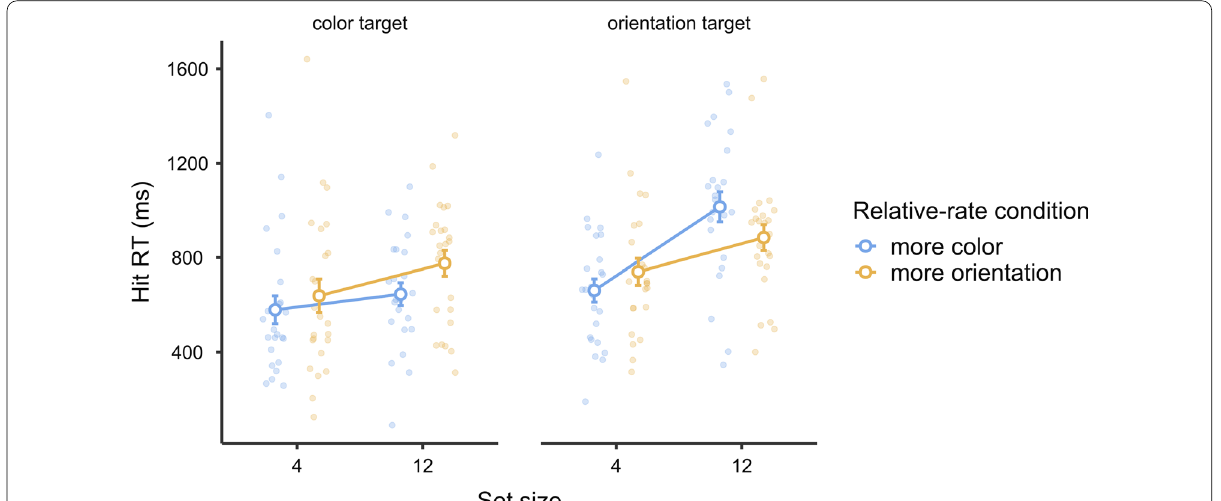
Fig. 6 Experiment 3 results: hit RTs. Note In Experiment 3, a relative target-rate effect occurred in terms of set-size effects. The search tended to be more efficient (smaller set-size effect) when the current target type was more frequent. Error bars represent